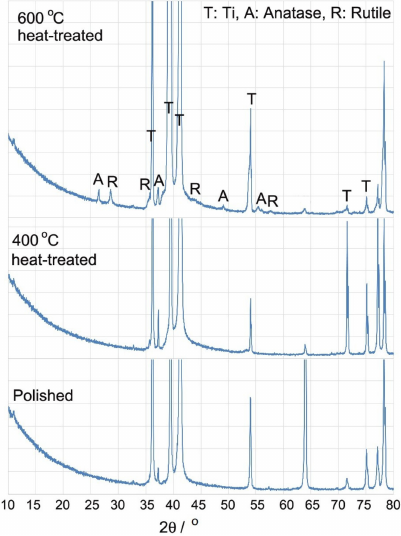
Figure 2. X-ray diffraction spectra of CP-Ti specimens after mechanical polishing, and 400 and 600 ◦ C heat treatment, before